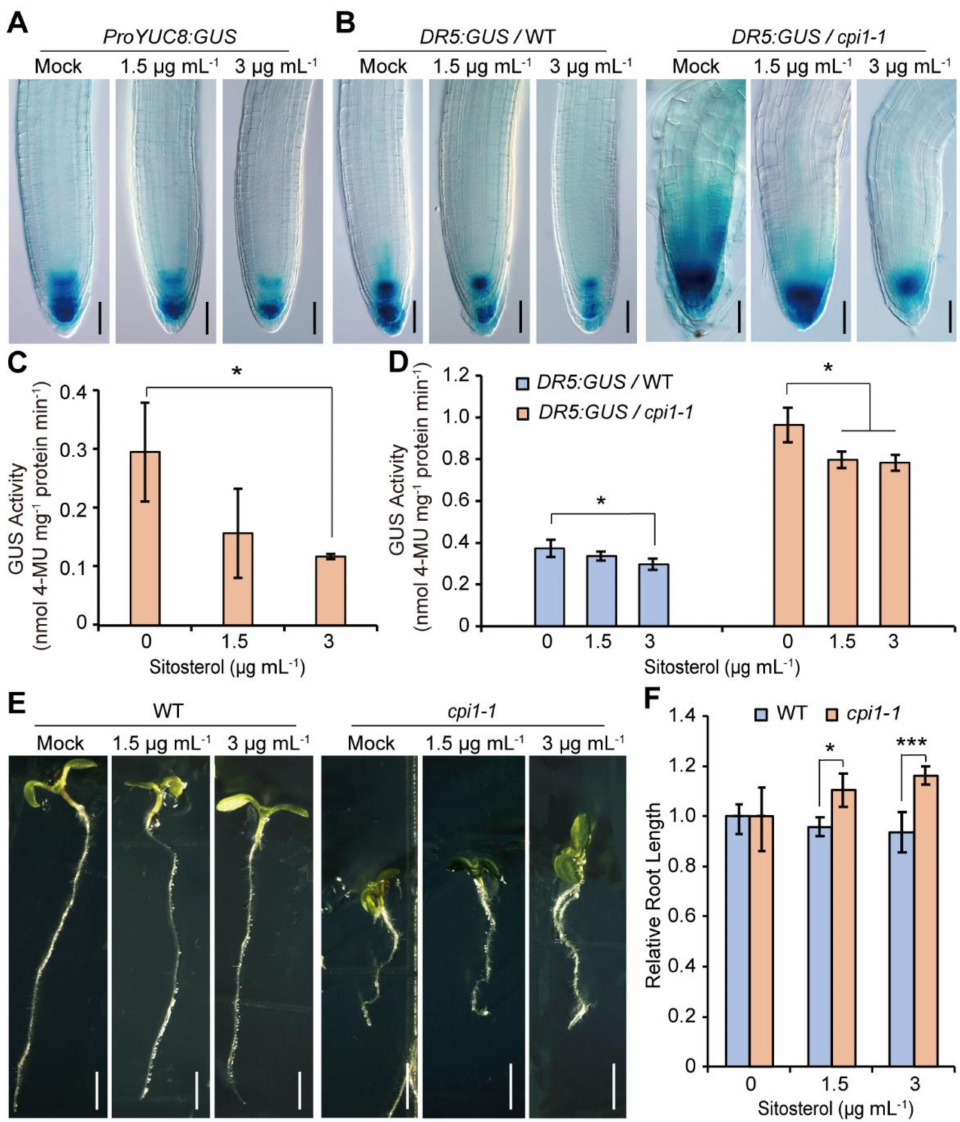
Figure 6. Sitosterol represses the expression of ProYUC8:GUS and DR5:GUS , and partially rescues the short root phenotype of cpi1-1 . ( A ) Expression of ProYUC8:GUS treated with or without sitosterol. The images are representative of n = 3 independent experiments employing 9 to 30 seedlings per experiment; ( B ) Expression of DR5:GUS in WT and cpi1-1 seedlings treated with or without sitosterol. The images are representative of n = 3 independent experiments employing 14 to 30 seedlings per experiment; ( C , D ) Quantitative GUS activity assay of ProYUC8:GUS ( C ) and DR5:GUS ( D ) in 5-day-old seedlings. Data are shown as means ± SD of n = 3 independent experiments. * p < 0.05 (one-way ANOVA with Tukey’s test); ( E , F ) Phenotypes ( E ) and relative root length ( F ) of WT and cpi1-1 seedlings grown on MS medium supplemented with different concentrations of sitosterol. Data are shown as means ± SD of n = 3 experiments (employing 12 to 45 roots per experiment). * p < 0.05, *** p < 0.001 (Student’s t -test, one-tailed, two-sample equal variance). Bars = 100 µ m in ( A , B ) and 1 mm in ( E